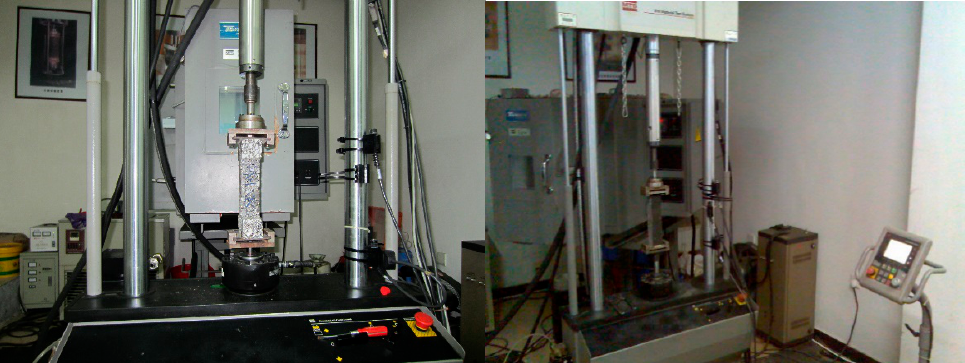
Figure 3. Material Test System (MTS).